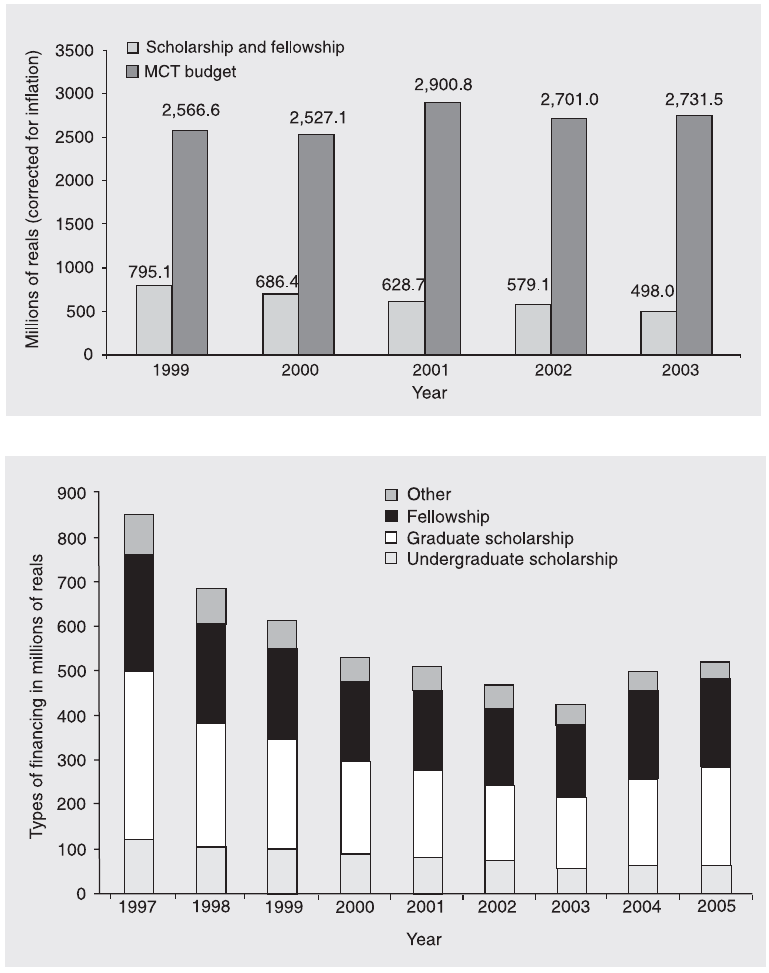
Figure 5. Ministry of Science and Technology (MCT) budget, in reals, between 1999 and 2003, and the amount spent on scholarships and fellowships, cor- rected for inflation using the IGP-DI, and considering 2002 as the reference point (original data source: Min- istry of Science and Technology, http://www.mct.gov. br/estat, and CNPq, http://fomentonacional.cnpq.br/ dmfomento/home/index.jsp).